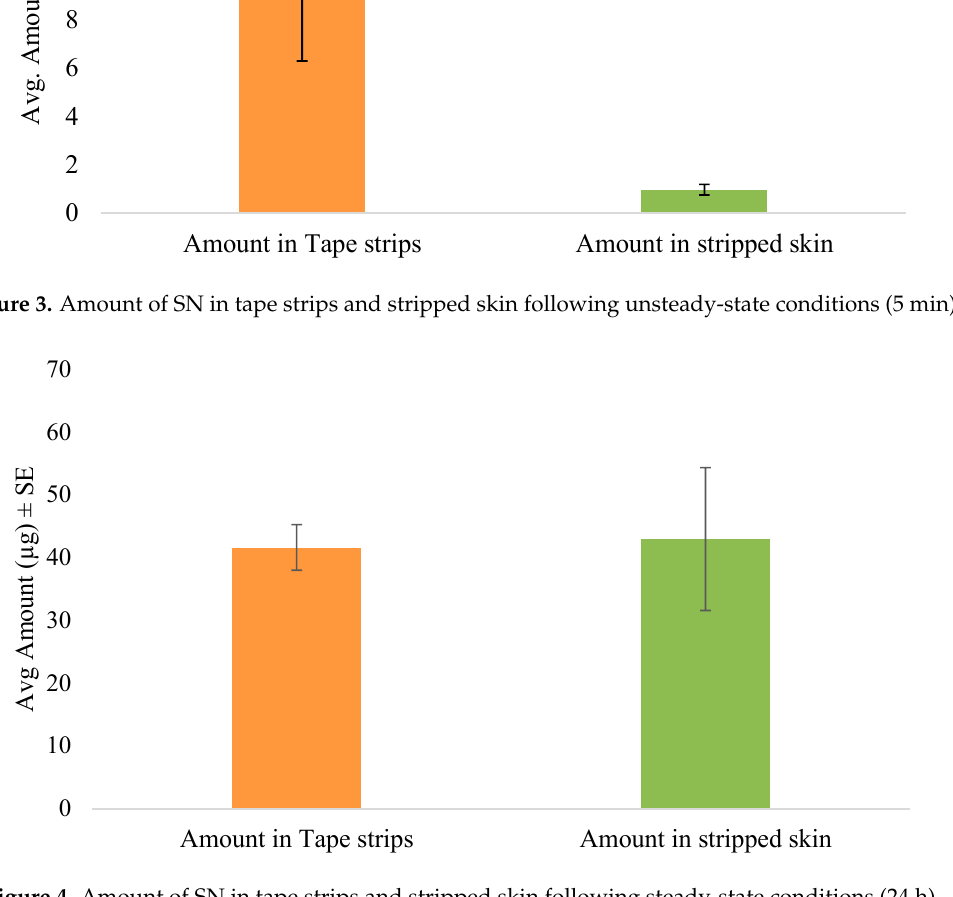
Figure 4. Amount of SN in tape strips and stripped skin following steady-state conditions (24 h).